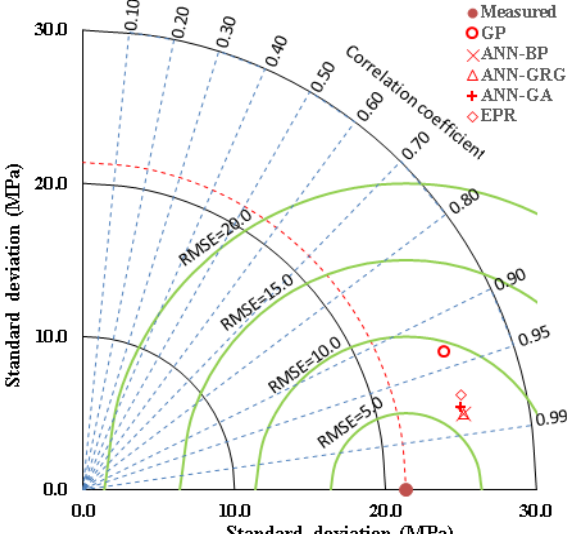
Figure 7. Taylor diagram of the predicted models.